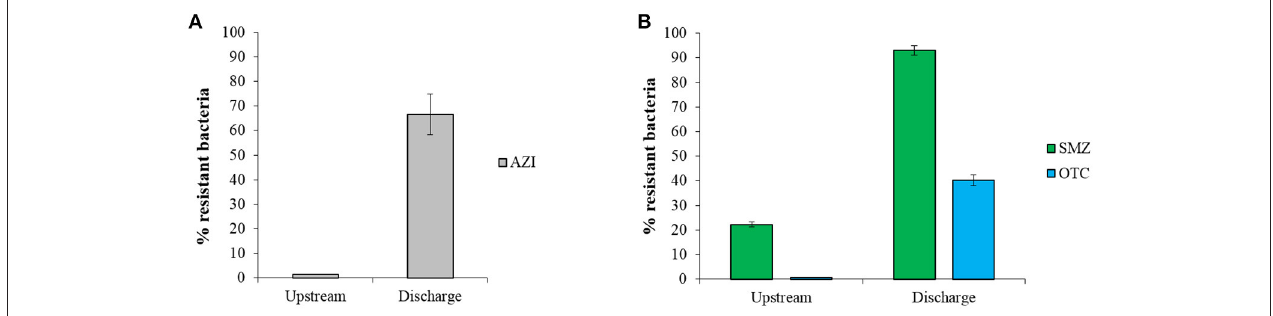
FIGURE 1 | The proportion of resistance (mean ± SD) of culturable bacteria to (A) azithromycin (AZI) and (B) sulfamethazine (SMZ) and oxytetracycline (OTC) in sediments from discharge and upstream sites of two study areas. The percentage of antibiotic resistant bacteria was calculated as the ratio of resistant bacteria CFU and total